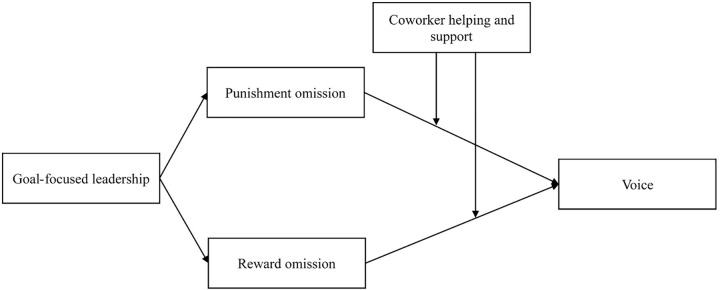
Theoretical model.